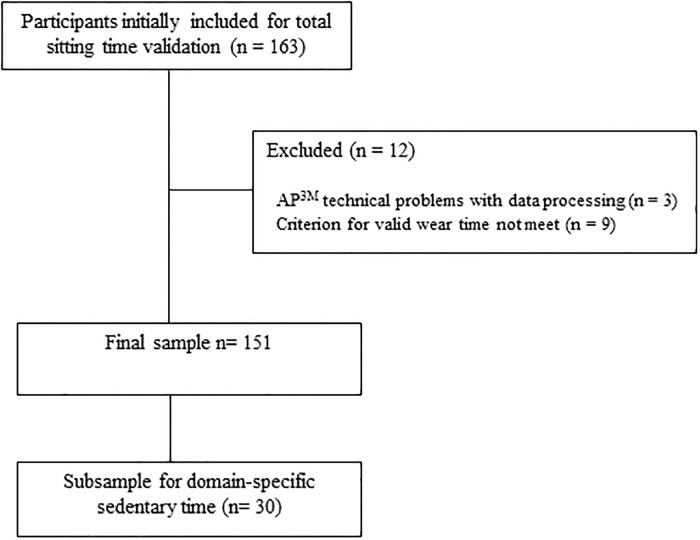
Samples flowchart.